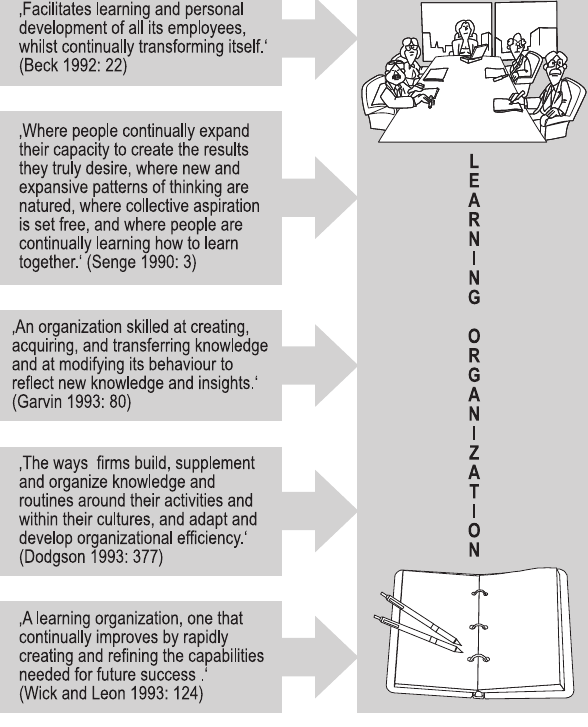
Fig. 1. Examples of Defi nitions of a Learning